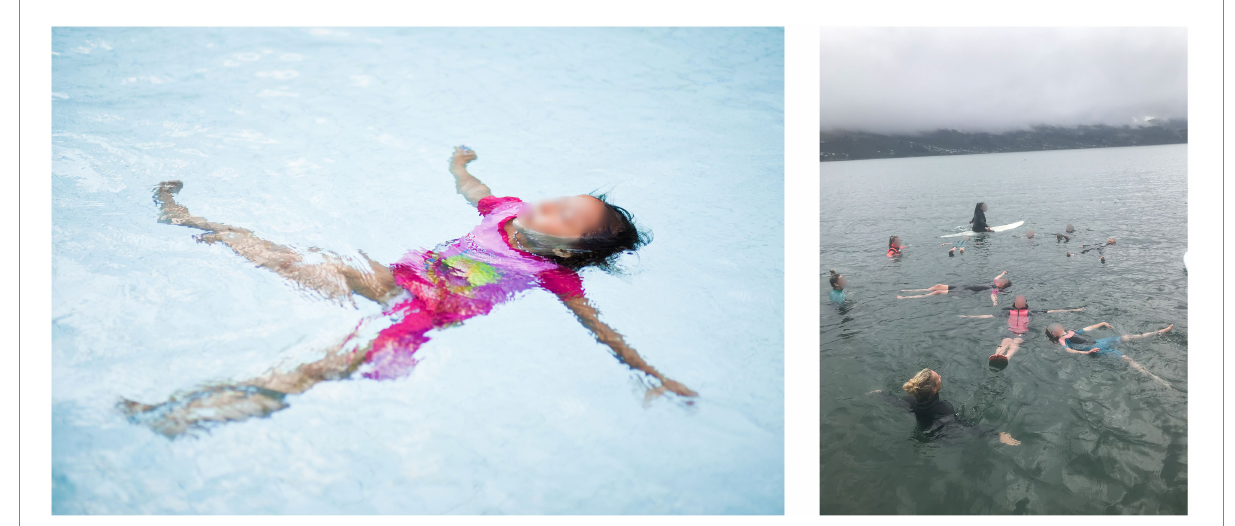
FIGURE 3 Impressions from the data collection: indoor testing in a pool (left) vs. outdoor testing in a harbor (right).